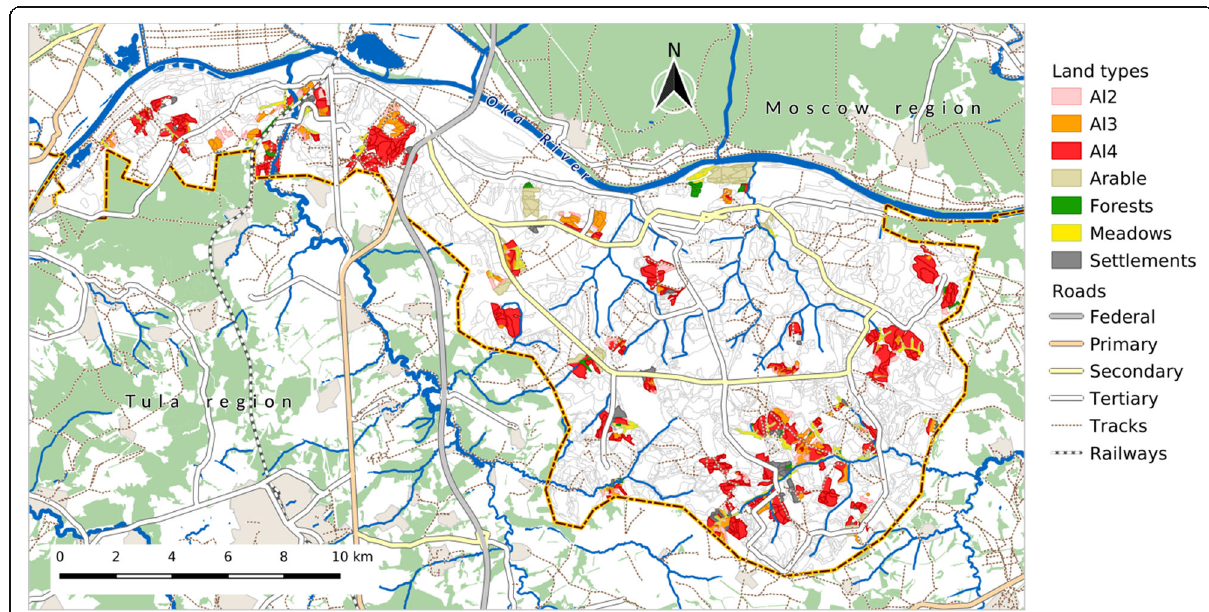
Fig. 5 Spatiotemporal clusters of lands (polygons) affected by fire from 1986 to 2014. Clusters were calculated by the OPTICS algorithm with the following parameters: ≥ 3 fire events in 300 m and 1 year time unit; cluster size ≥ 10